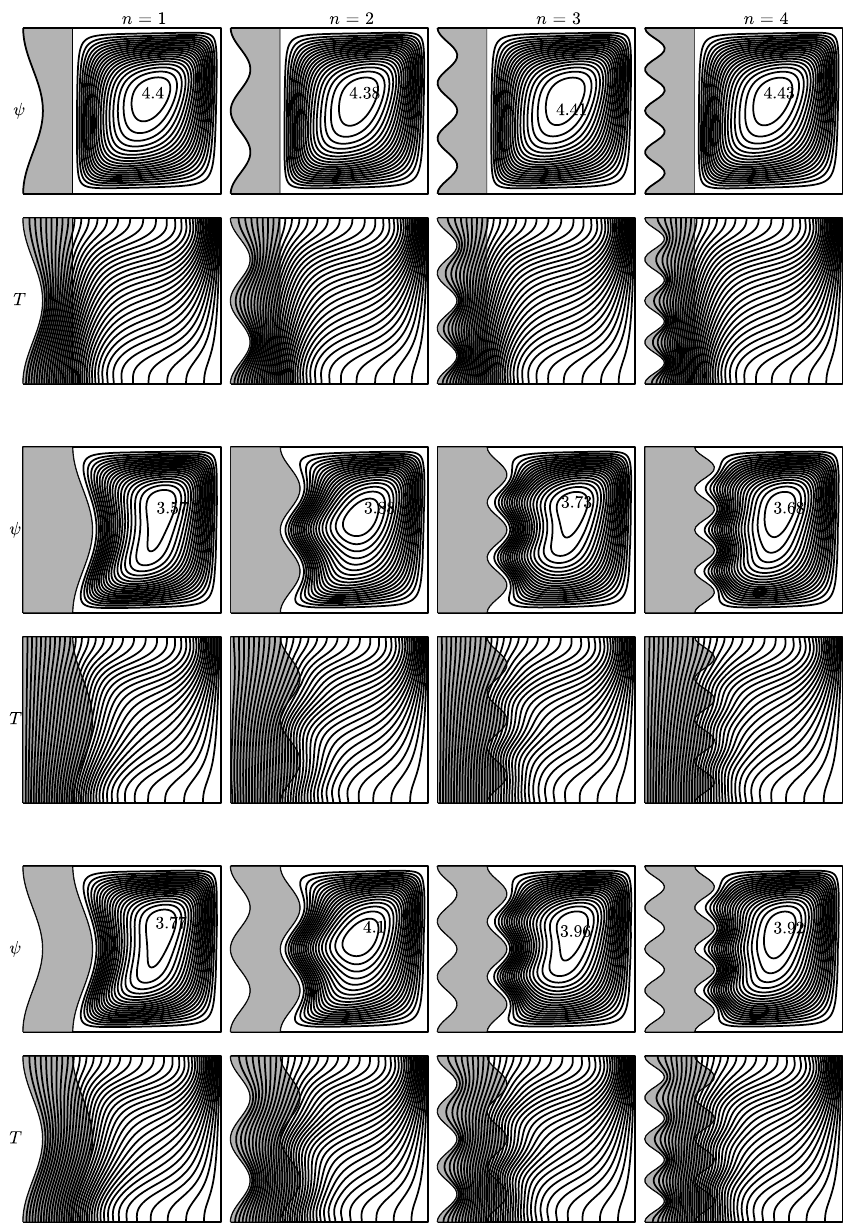
Figure 8. Variation in n when Ra = 10 5 , Ha = 25, kr = 1, γ = 0 ◦ , A = 0.05. Streamlines and isotherms at the ( top ) is for case 1, at the ( middle ) is for case 2 and the at ( bottom ) is for case